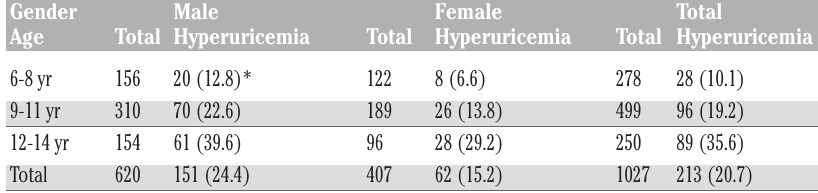
Table 1. Number of subjects with hyperuricemia in relation to age and gender.